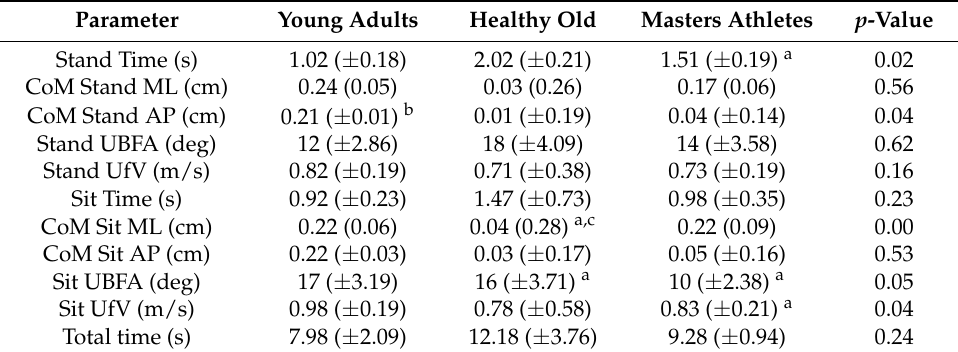
Table 3. Computed results for the sit-to-stand motion for each participant